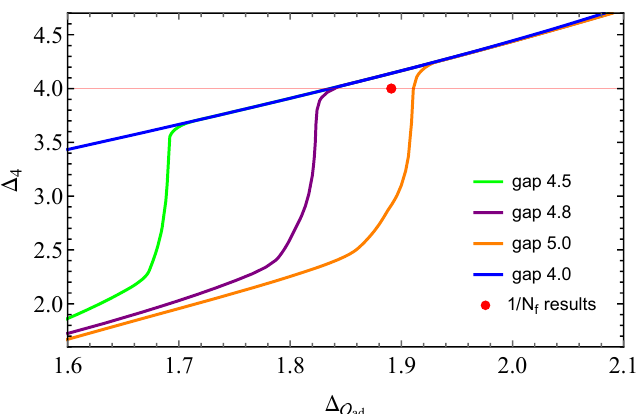
Figure 7 . Bounds on ∆ 4 with different gap assumptions ∆ ∗ T ¯ A